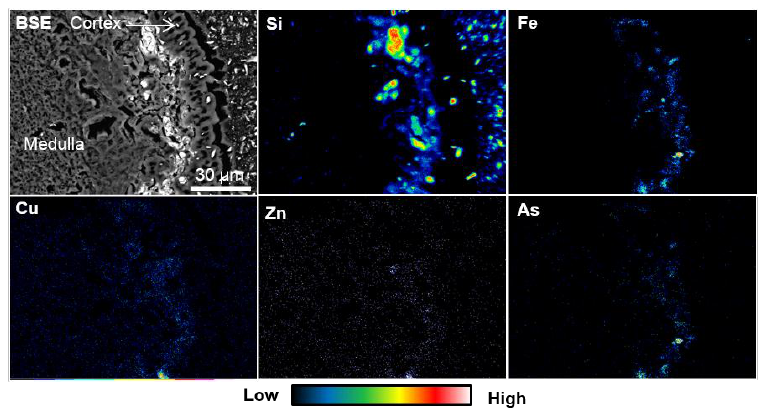
Figure 8. A back-scattered electron image and the elemental maps of the lichen thallus.